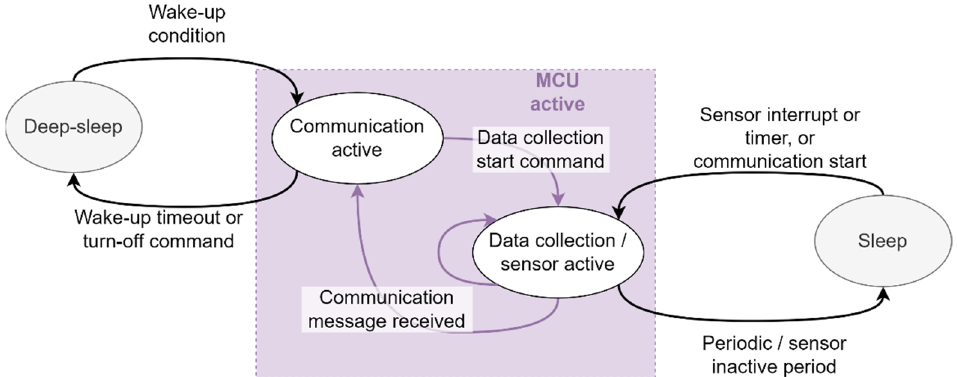
Figure 6. State diagram for seaweed sensor operations.